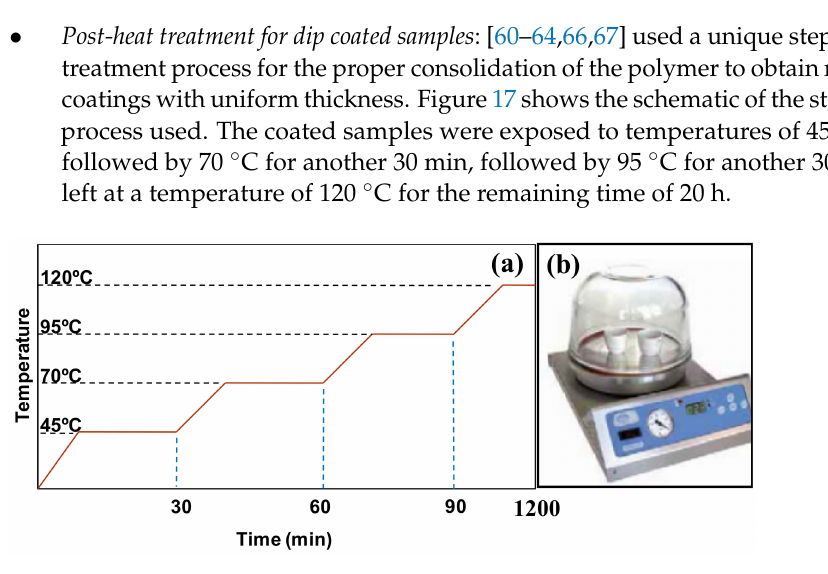
Figure 17. ( a ) Schematic of the stepwise post-heat treatment used for the consolidation of the UHMWPE nanocomposite coatings [60–64,66,67]. ( b ) The heating plate used for the post-heat treatment